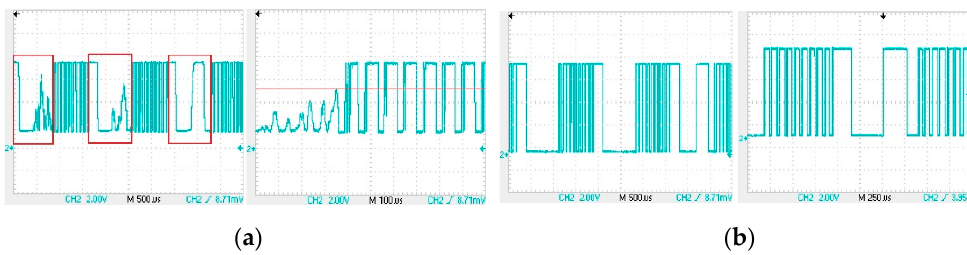
Figure 11. Waveform diagram of OUT1 signal and OUT2 signal: ( a ) output OUT1 of the amplifier circuit; ( b ) output OUT2 of the first comparator.